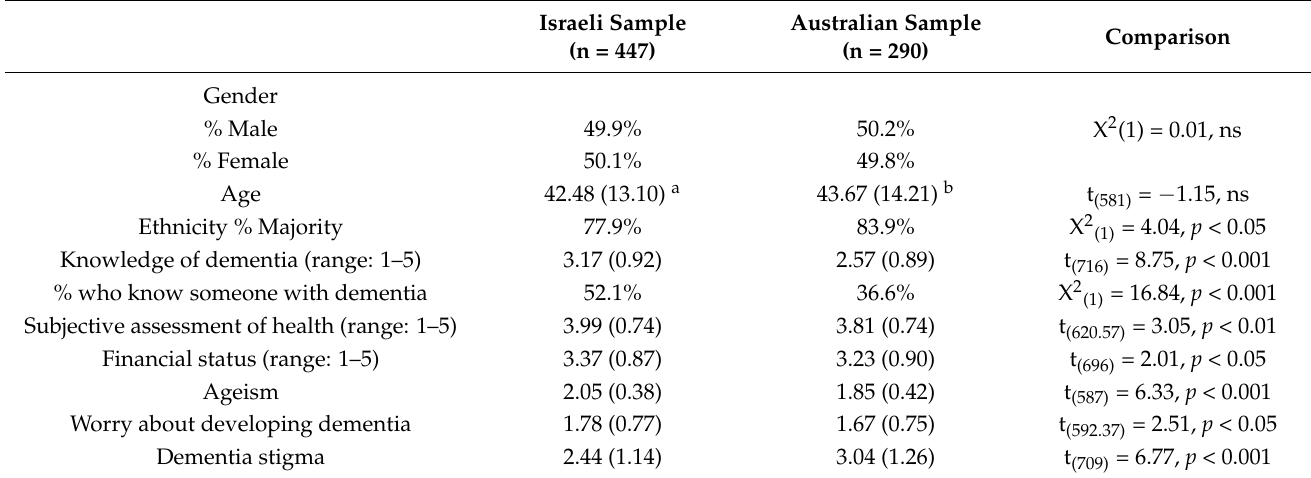
Table 1. Descriptive statistics of participants (% or mean